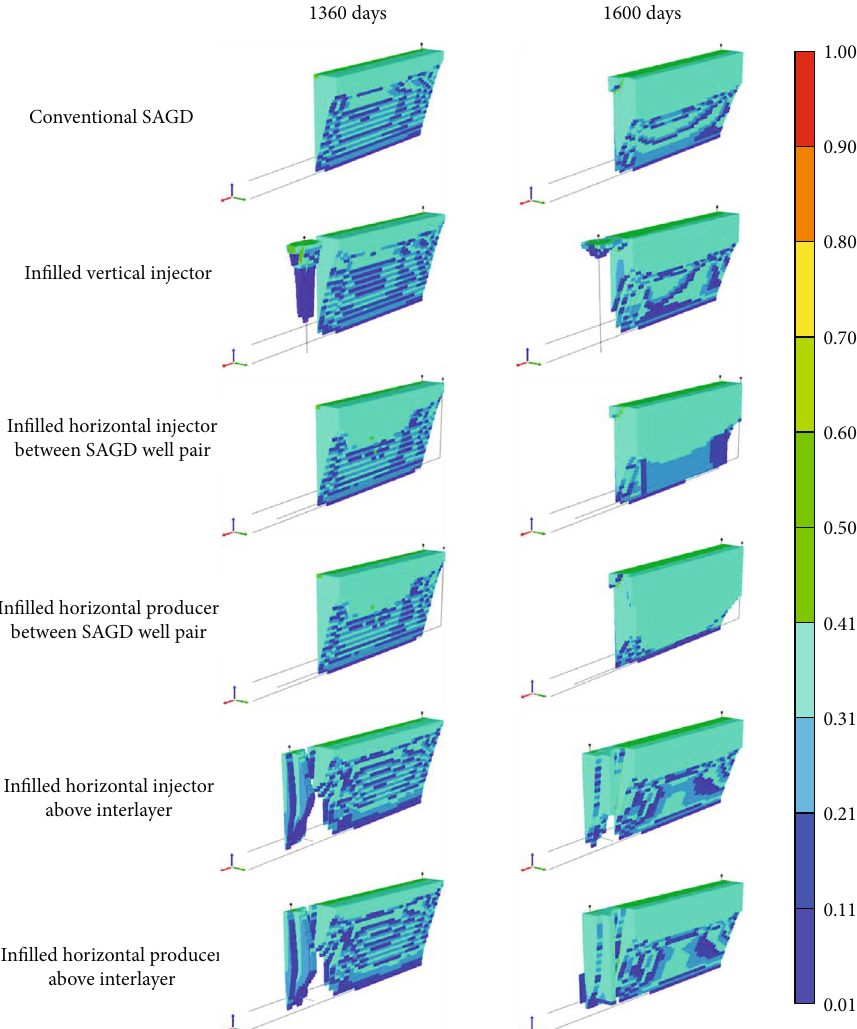
Figure 13: Gas saturation of the di ff erent schemes for model C at di ff erent